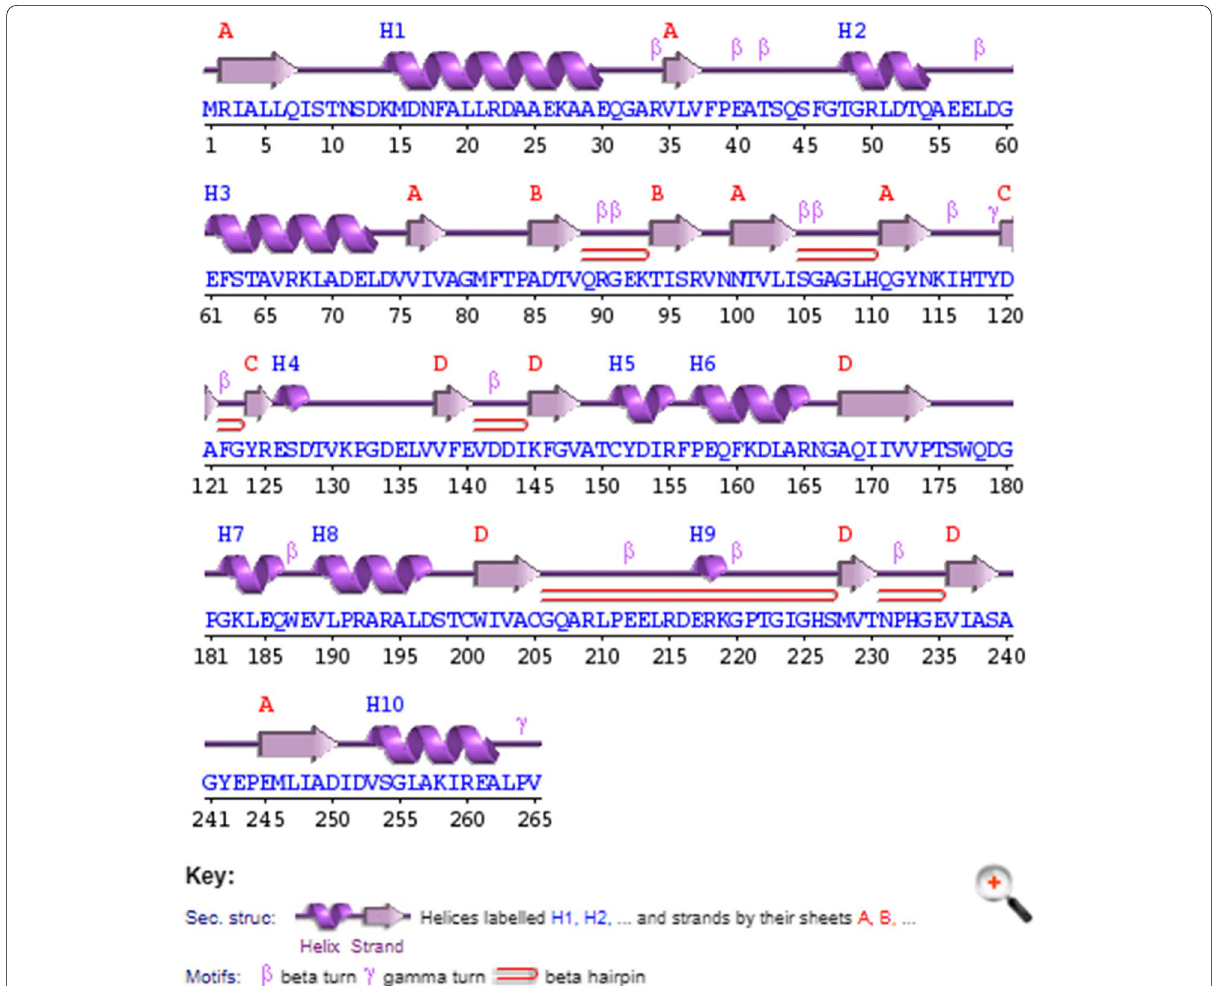
Fig. 4 Graphical representation of the predicted secondary structures of nitrilase-3